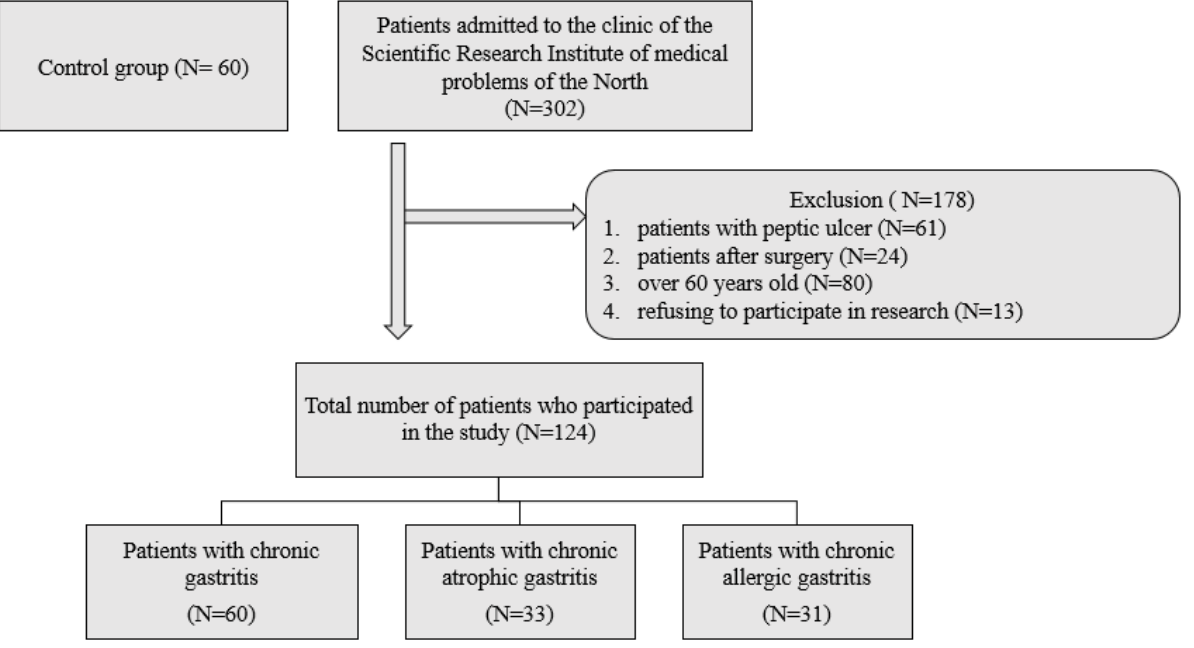
Figure 1. Scheme of inclusion of patients in the study.